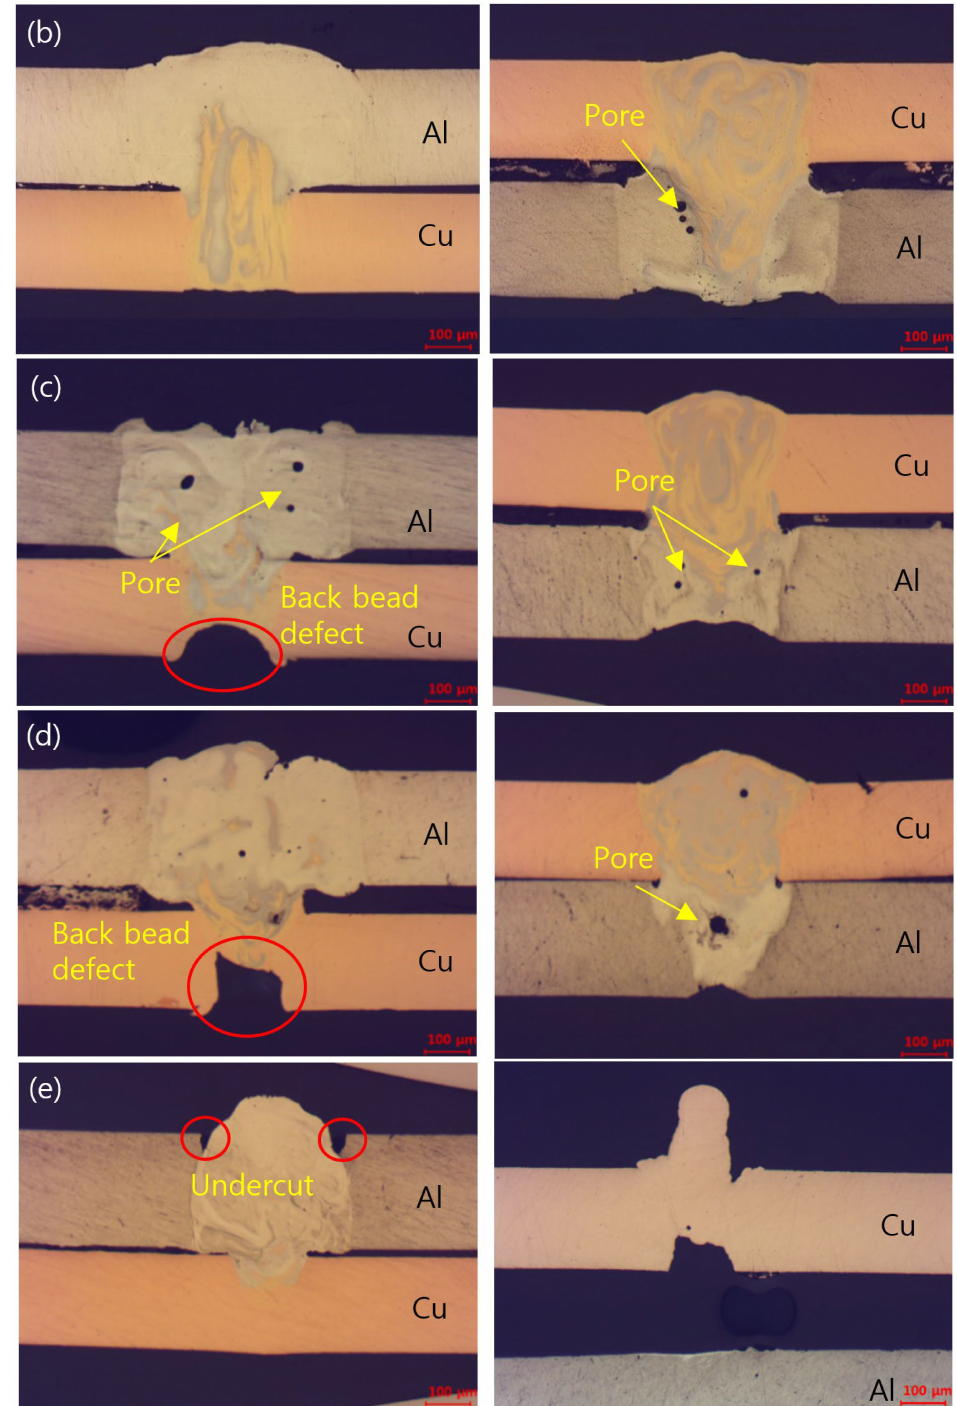
Figure 2. The cross-sectional images recorded under different welding conditions. The left-hand images show Al as the upper material, while that of the right-hand show Cu as the upper material. The welding speeds employed in each pair of images were as follows: ( a ) 200 mm/s, ( b ) 400 mm/s, ( c ) 600 mm/s, ( d ) 800 mm/s, and ( e ) 1000 mm/s. In addition, from Figure 2a, it is deduced that pores with diameters of 100–150 µ m are generated in the Al molten zone. More specifically, depending on the melting point and cooling rate during the welding process, pores form between the solid Cu area and the molten Al. When Al is used as the upper material, several pores with a diameter of ≤ 10 µ